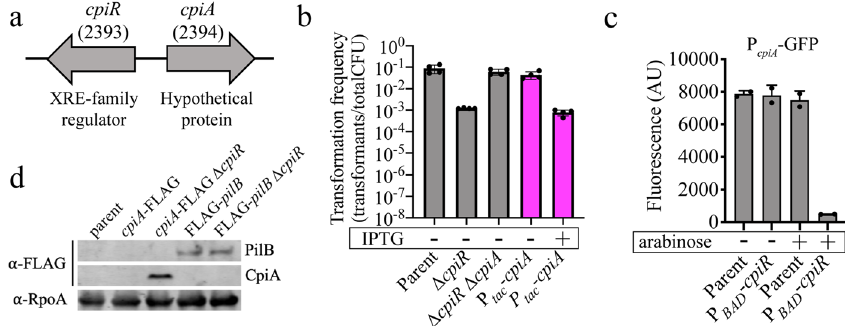
Fig. 3 Natural transformation is regulated by the inhibitor protein, CpiA, whose expression is controlled by the transcriptional repressor, CpiR. a Schematic of cpiRA locus organization. Numbers in parentheses are ACIAD numbers associated with each gene. b Natural transformation assays of the indicated strains performed with or without 100 µ M IPTG added as indicated. Each data point represents a biological replicate ( n = 4) and bar graphs indicate the mean ± SD. Pink bars denote a strain where cpiA is expressed at an ectopic location under the control of an IPTG-inducible promoter. c Fluorescence intensity of V. cholerae strains harboring a P cpiA -GFP reporter and a P BAD - cpiR ectopic expression construct as indicated when grown with or without 0.2% arabinose as indicated. Each data point represents a biological replicate ( n = 2) and bar graphs indicate the mean ± SD. d Western blot showing CpiA-FLAG production in the indicated strains and PilB levels when CpiA is expressed. RpoA was detected as a loading control. Source data are provided as a Source Data fi